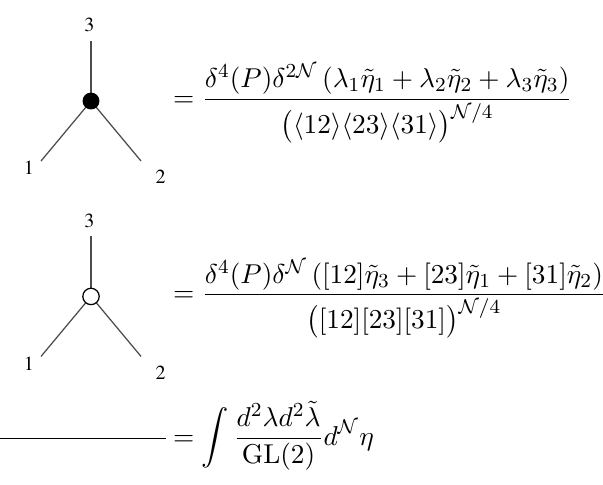
Figure 1 . Vertices and edges for on shell diagrams in N = 4 SYM and N = 8